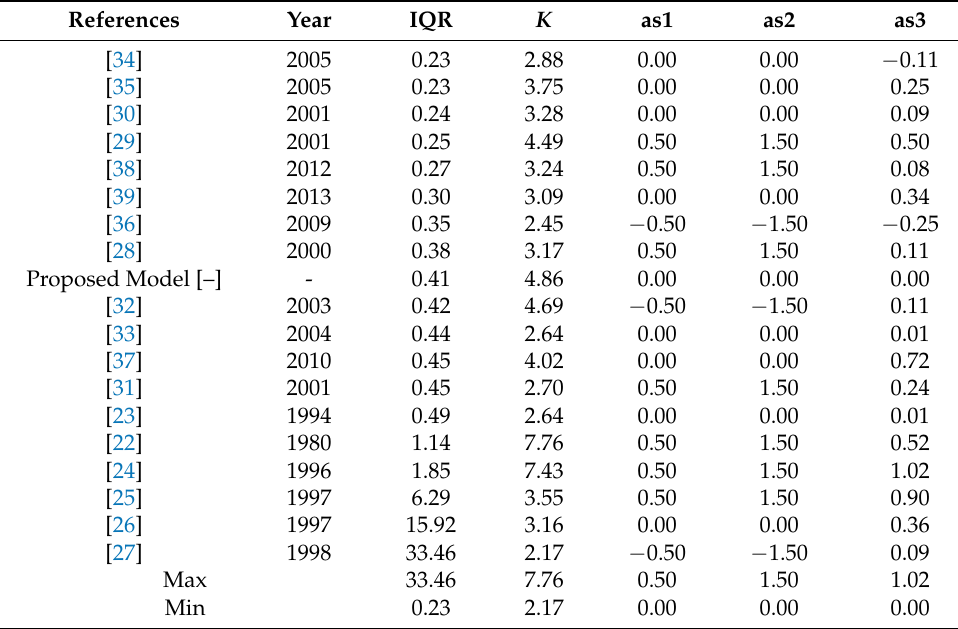
Figure 13. Variable of importance: the %IncMSE. Table 4. Comparison of the precision and the accuracy of the analyzed models.